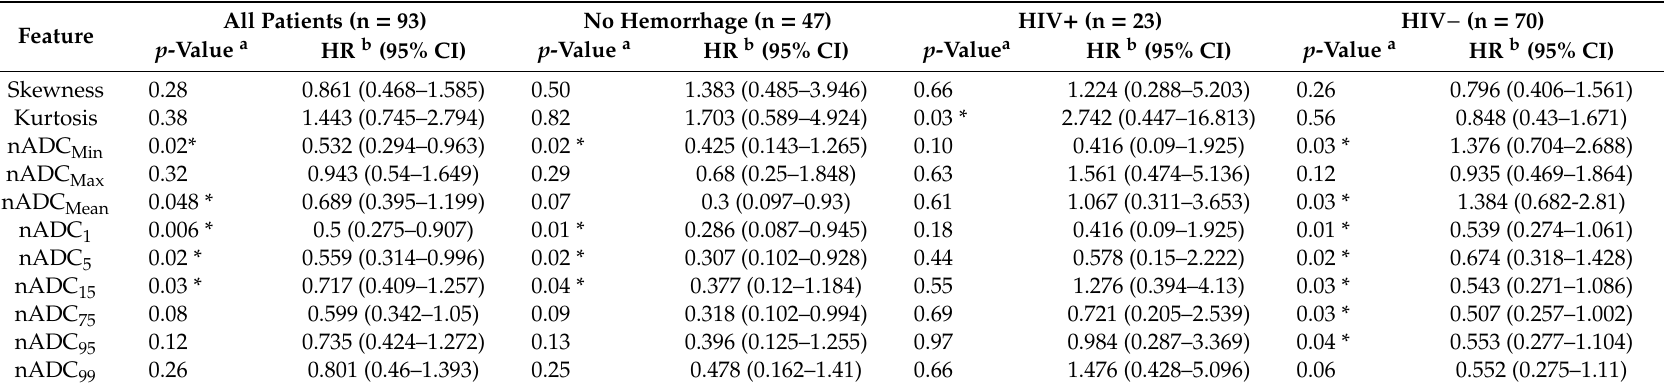
Table 4. Hazard ratios for overall survival in all patients and patients without lesion hemorrhage. Results are considered significant (*) when p < 0.05.